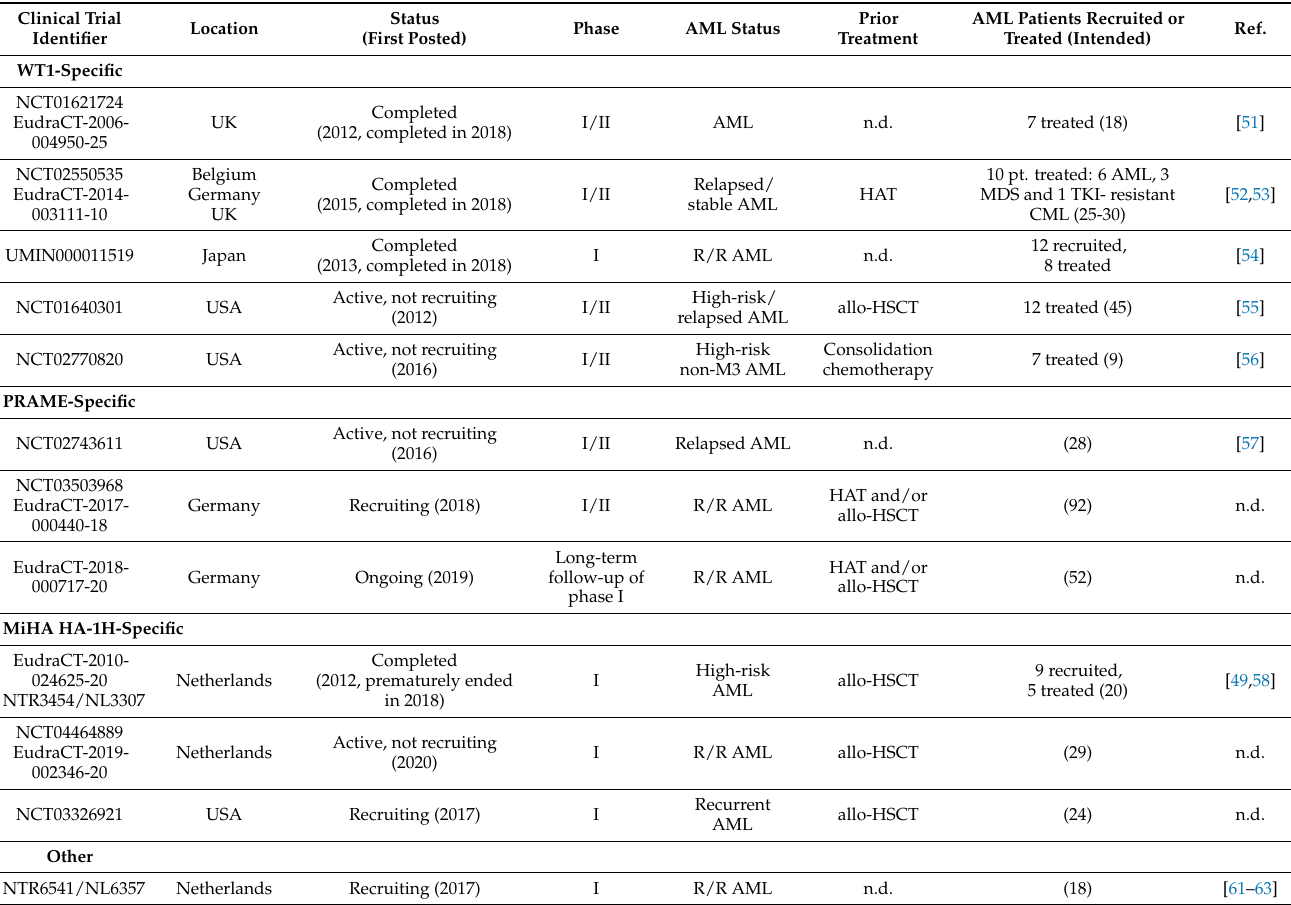
Table 1. Clinical trials using TCR-T cells for AML.